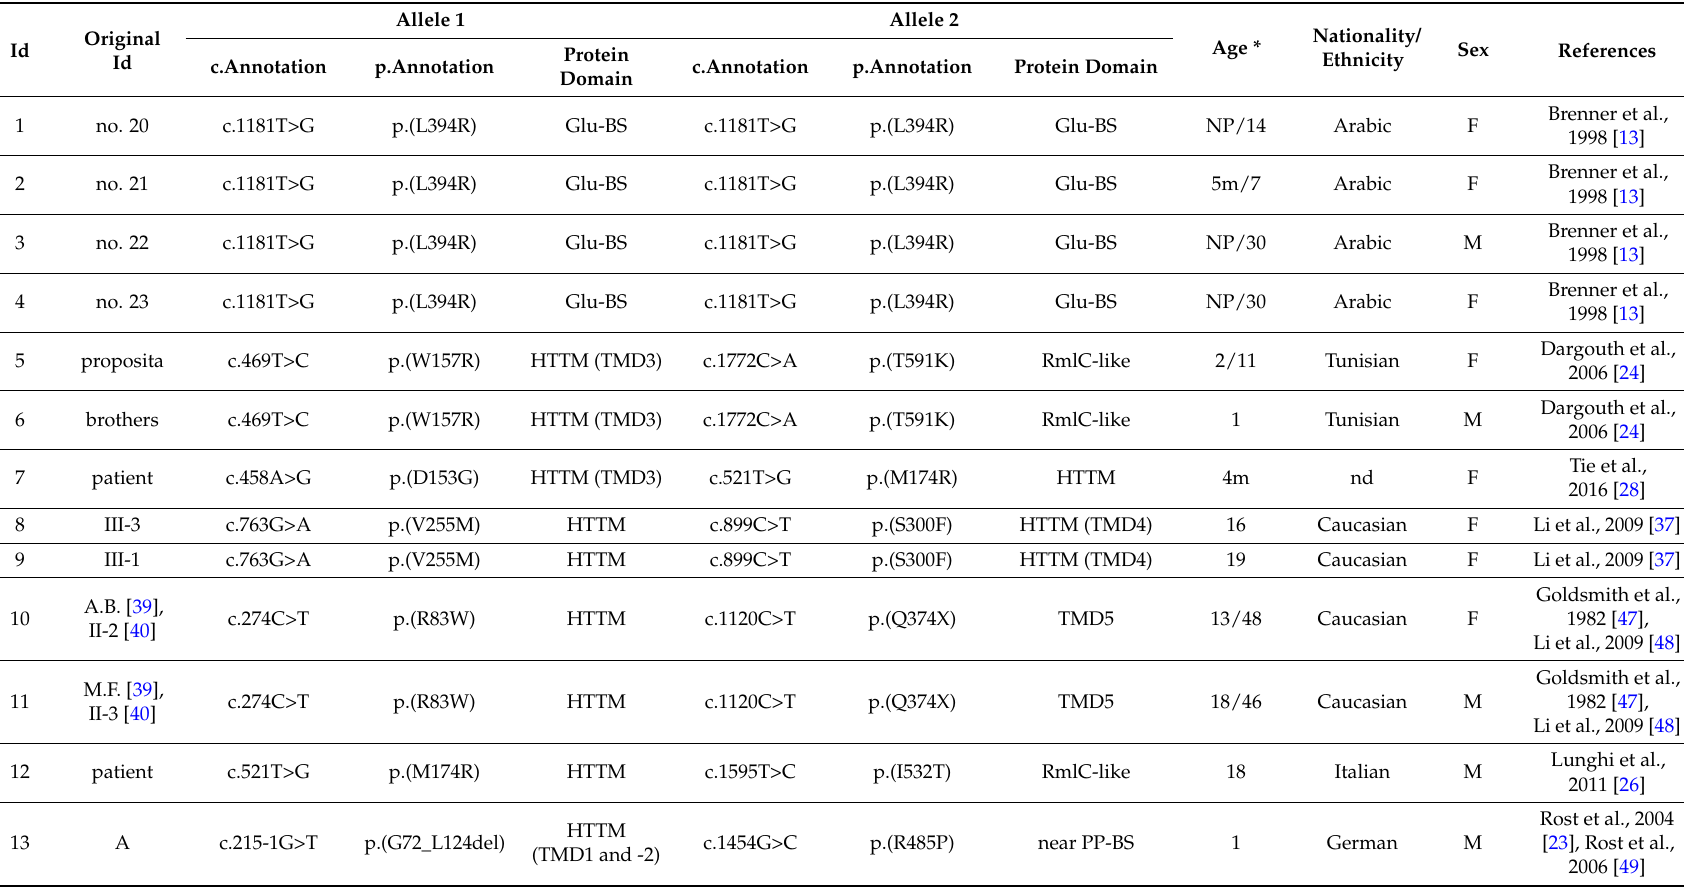
Table 2. Patient characteristics. This table gives an overview of all the patients included in this systematic review. For each patient the GGCX mutations are mentioned (cDNA and protein annotation) as well as the protein domain in which the affected amino acid is situated. Further, for each patient, the age, nationality/ethnicity and sex are